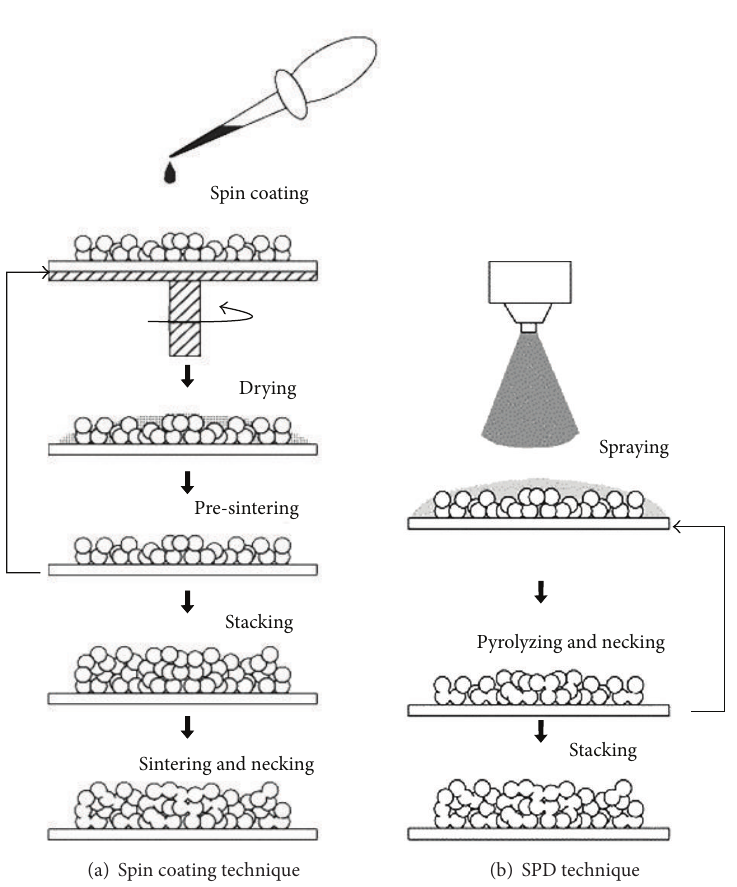
Figure 11: Comparison between spin coating and SPD methods [81].